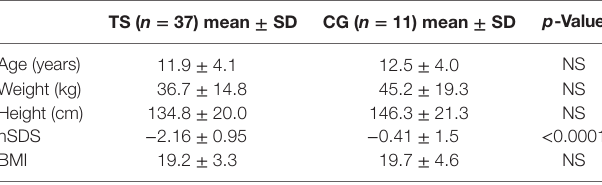
Table 1 | Clinical parameters—girls with TS vs. healthy controls (mean ± SD).